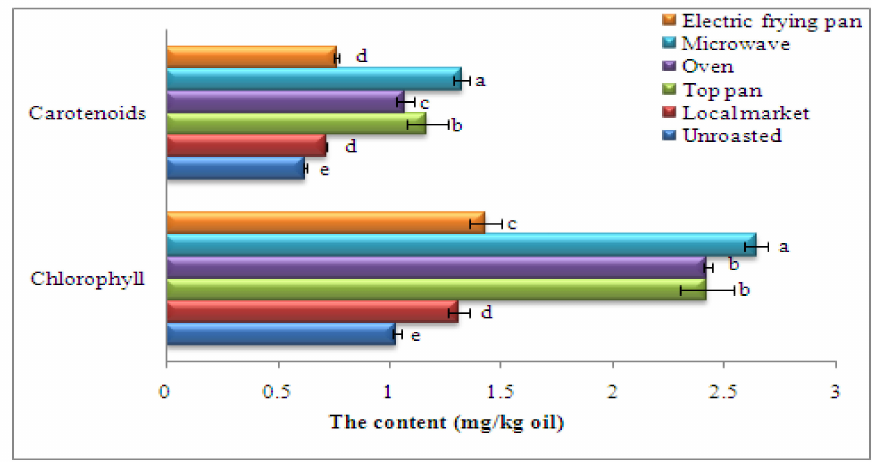
Figure 1. Chlorophyll and carotenoid contents (mg/kg oil) of oil recovered from sesame seeds roasted by different methods. Significant variations at p ≤ 0.05 are indicated by vertical bars with SD (n = 3) and different letters on the bars of every sample.